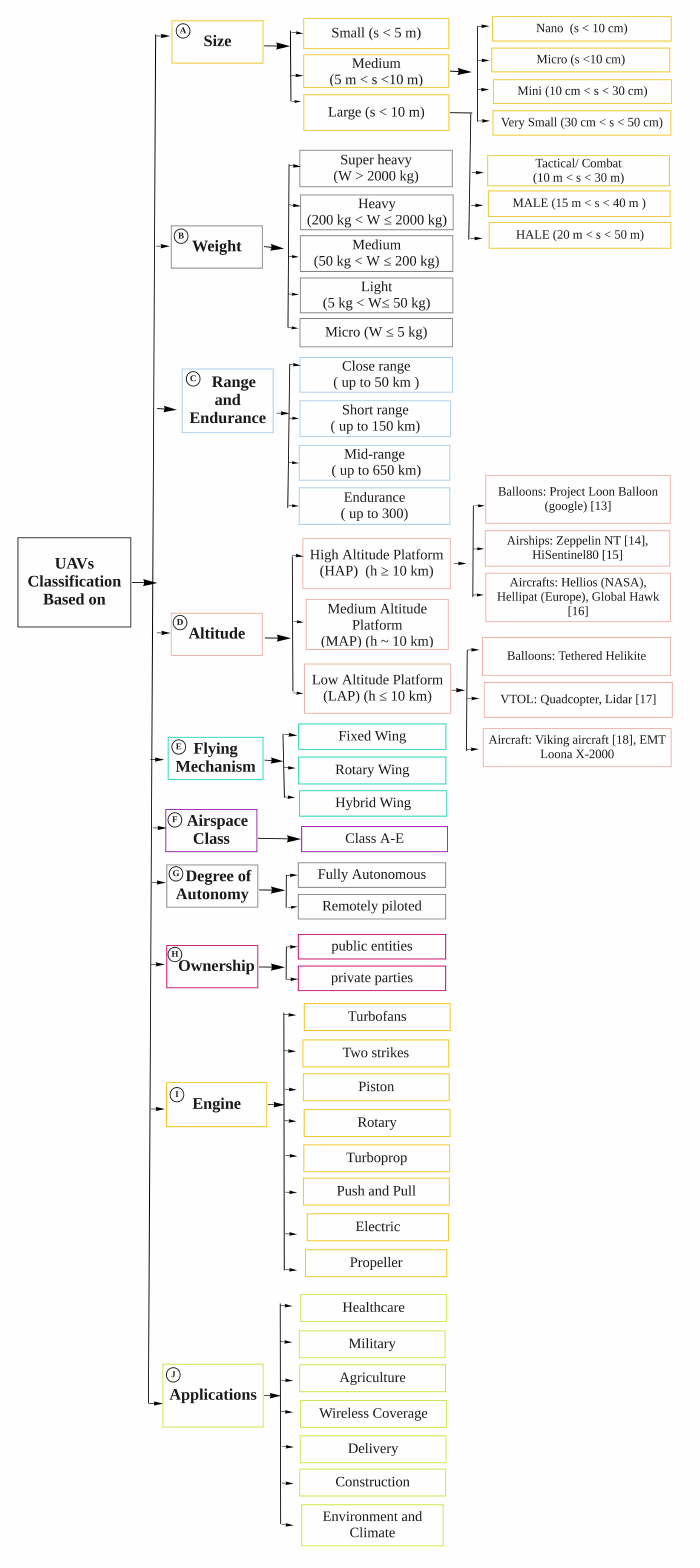
Figure 1. UAV Classification based on different features such as size, weight, range and en- durance, altitude, flying mechanism, airspace class, degree of autonomy, ownership, type of engine, and